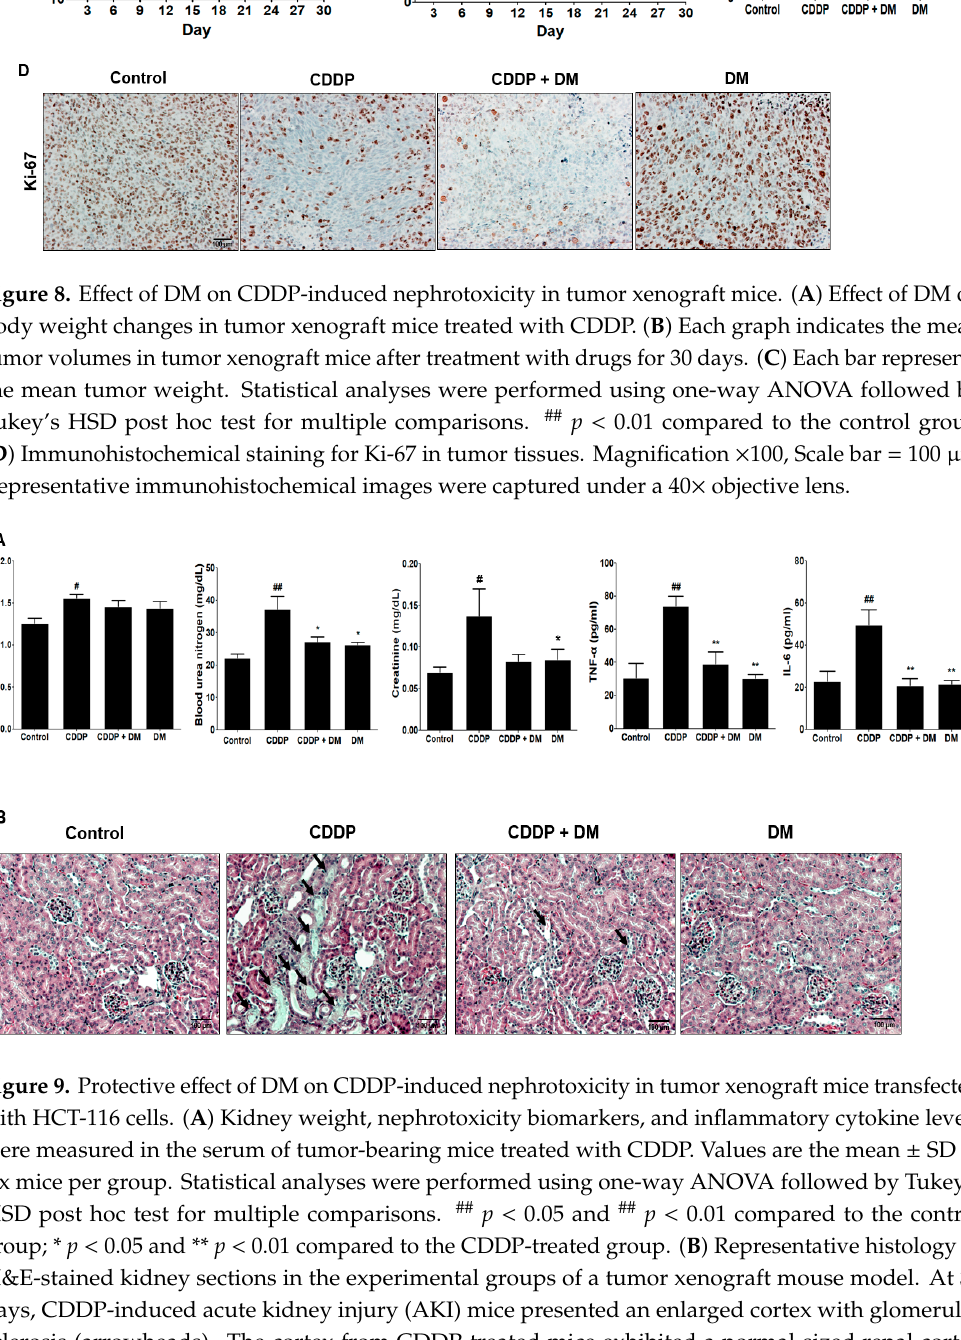
(magnification × 100, bar = 100 µ